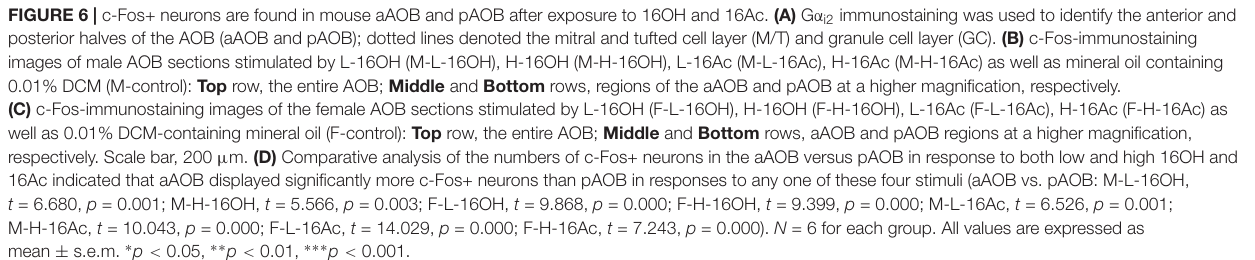
FIGURE 6 | c-Fos+ neurons are found in mouse aAOB and pAOB after exposure to 16OH and 16Ac. (A) G α i2 immunostaining was used to identify the anterior and posterior halves of the AOB (aAOB and pAOB); dotted lines denoted the mitral and tufted cell layer (M/T) and granule cell layer (GC). (B) c-Fos-immunostaining images of male AOB sections stimulated by L-16OH (M-L-16OH), H-16OH (M-H-16OH), L-16Ac (M-L-16Ac), H-16Ac (M-H-16Ac) as well as mineral oil containing 0.01% DCM (M-control): Top row, the entire AOB; Middle and Bottom rows, regions of the aAOB and pAOB at a higher magnification, respectively. (C) c-Fos-immunostaining images of the female AOB sections stimulated by L-16OH (F-L-16OH), H-16OH (F-H-16OH), L-16Ac (F-L-16Ac), H-16Ac (F-H-16Ac) as well as 0.01% DCM-containing mineral oil (F-control): Top row, the entire AOB; Middle and Bottom rows, aAOB and pAOB regions at a higher magnification, respectively. Scale bar, 200 µ m. (D) Comparative analysis of the numbers of c-Fos+ neurons in the aAOB versus pAOB in response to both low and high 16OH and 16Ac indicated that aAOB displayed significantly more c-Fos+ neurons than pAOB in responses to any one of these four stimuli (aAOB vs. pAOB: M-L-16OH, t = 6.680, p = 0.001; M-H-16OH, t = 5.566, p = 0.003; F-L-16OH, t = 9.868, p = 0.000; F-H-16OH, t = 9.399, p = 0.000; M-L-16Ac, t = 6.526, p = 0.001; M-H-16Ac, t = 10.043, p = 0.000; F-L-16Ac, t = 14.029, p = 0.000; F-H-16Ac, t = 7.243, p = 0.000). N = 6 for each group. All values are expressed as mean ± s.e.m. ∗ p < 0.05, ∗∗ p < 0.01, ∗∗∗ p <